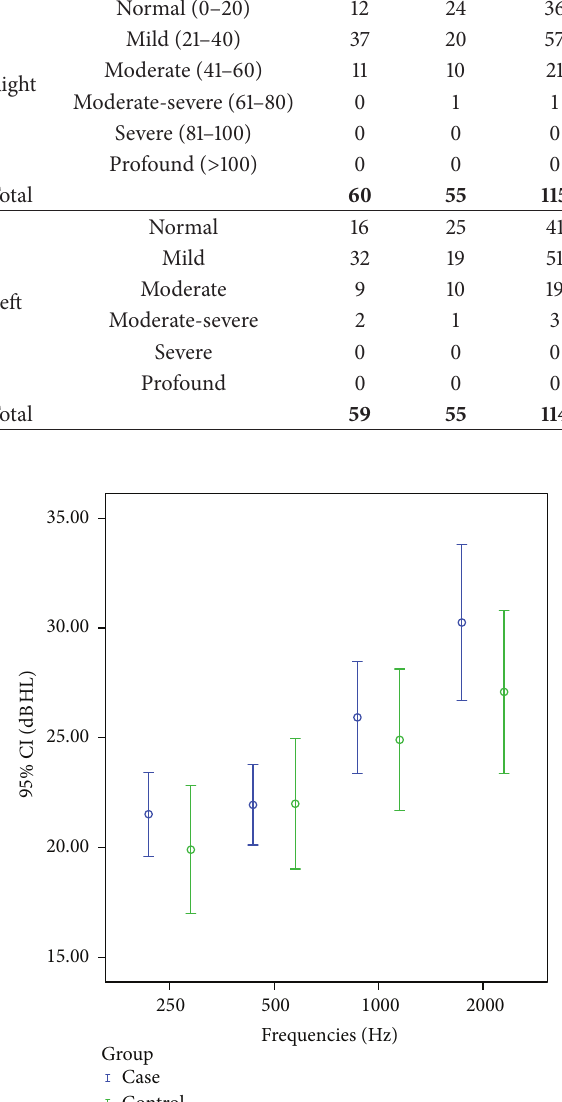
Figure 1: Left ear mean hearing threshold levels (95% confidence interval (CI), decibels (dB), and hearing level (HL) in 4 frequencies in Hz in case and control groups).